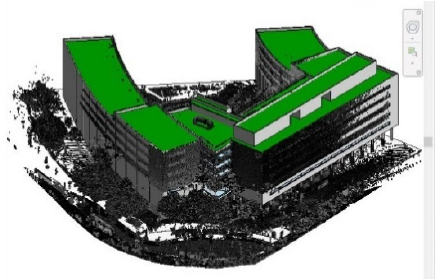
Figure 20. BIM model in Autodesk Revit software. School of Engineering building. Campus UPV/EHU DSS, Zone 2 of the scan.